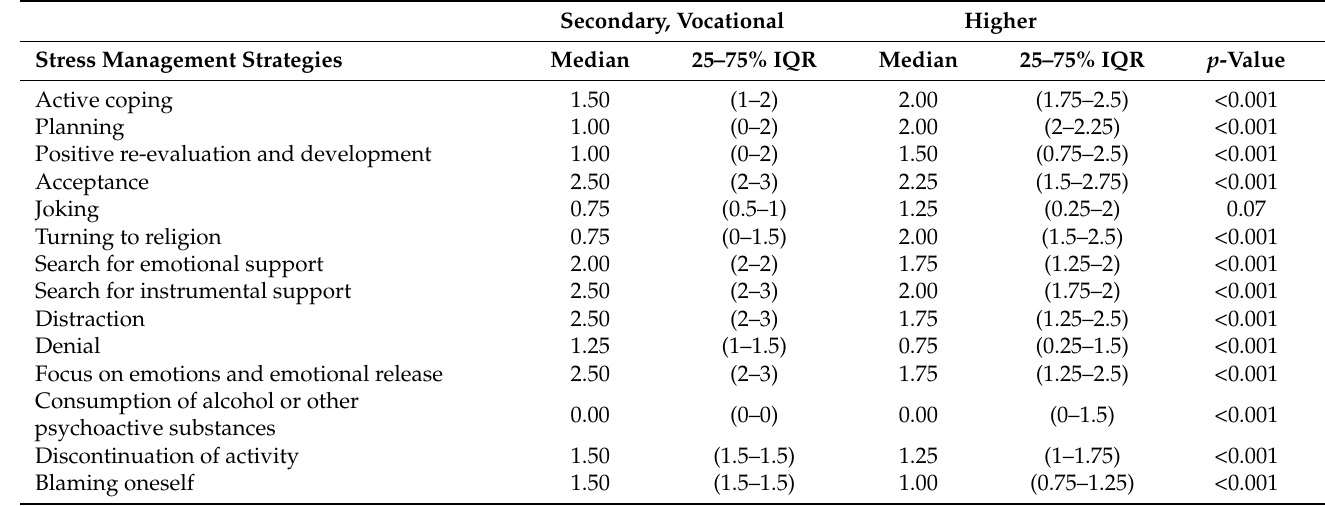
Table 5. Stress management strategies according to education.